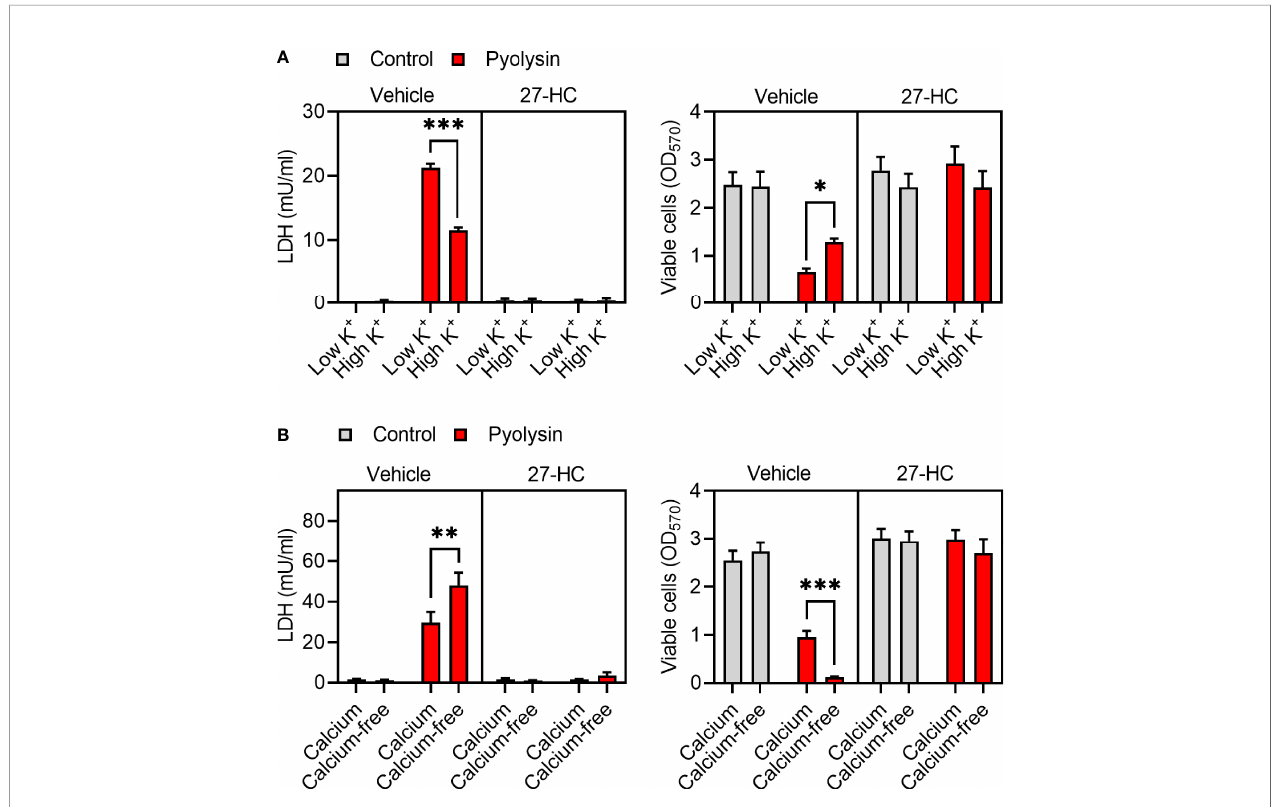
FIGURE 5 | Potassium and calcium do not affect 27-hydroxycholesterol cytoprotection. HeLa cells were cultured for 24 h in serum-free medium with vehicle or 10 ng/ml 27-hydroxycholesterol (27-HC), and then challenged with control medium ( ■ ) or 100 HU pyolysin ( ■ ) for 2 h in (A) low or high-potassium medium, or (B) in calcium-containing or calcium-free medium. The leakage of LDH was measured in cell supernatants and viable cells assessed by MTT assay. Data are presented as mean + s.e.m. with dots representing the values of cells from 4 independent experiments; statistical signi fi cance was determined using ANOVA with Tukey ’ s post hoc test, ***P < 0.001, **P < 0.01, *P <